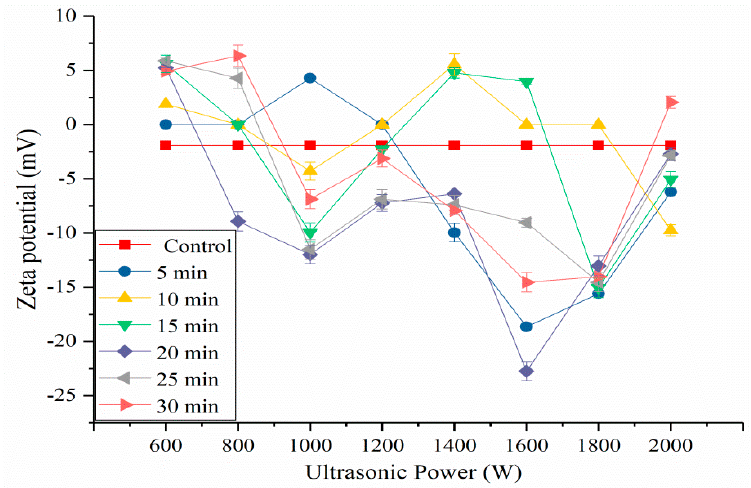
Figure 6. Zeta-potential value of HIU-treated SPI.